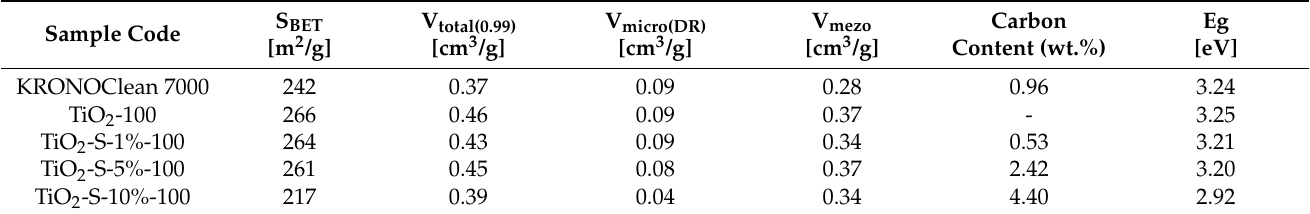
Table 2. Structural parameters, carbon contents and Eg values of the studied photocatalysts.